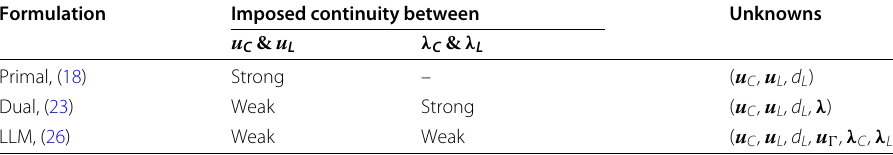
Table2 Domain decomposition formulations of the reference problem (4)